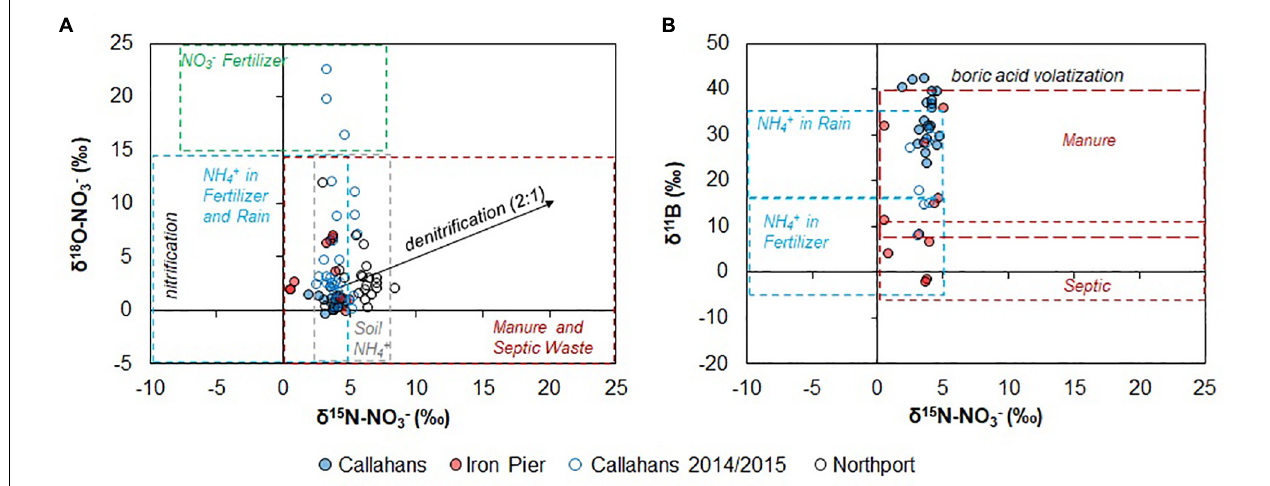
are based on a survey of possible sources on Long Island as well as the ranges reported by Vengosh et al. (1994, 1999), Bassett et al. (1995); Komor (1997), Seiler (2005), Widory et al. (2005), Tirez et al. (2010), and Eppich et al. (2013). Only select samples from Callahans 2014/2015 are included (salinity ≤